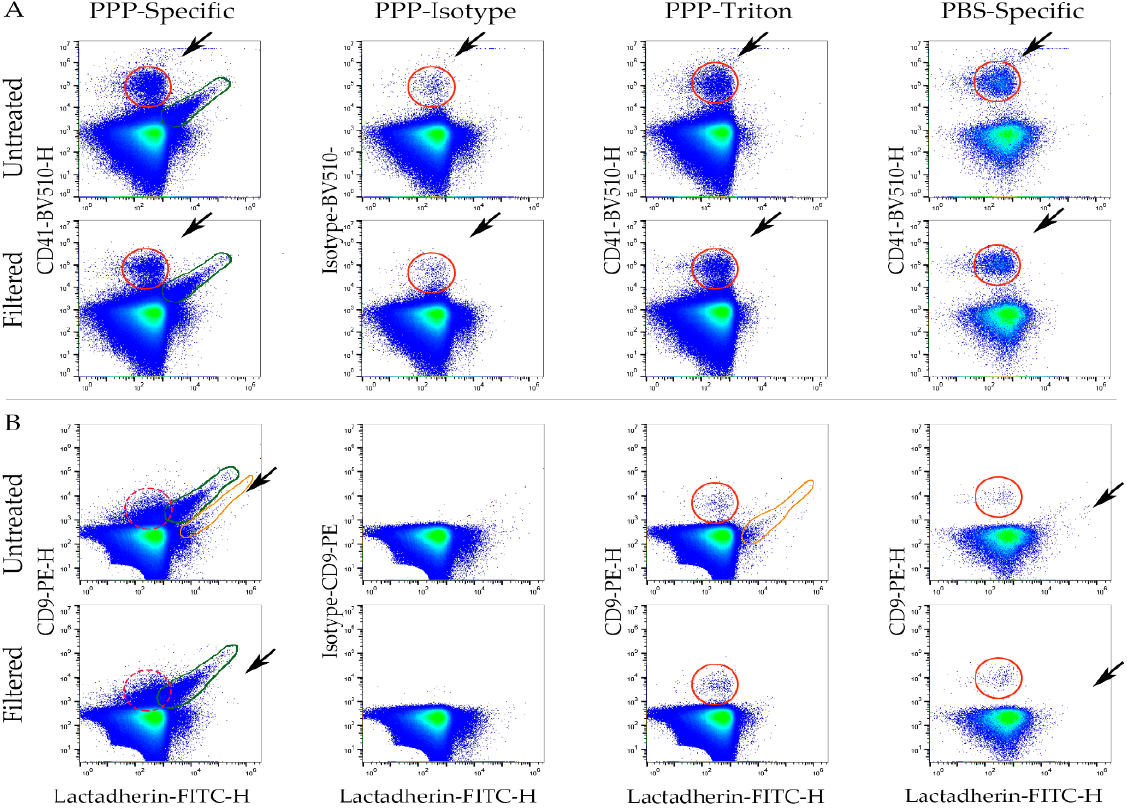
Figure 4. Scatterplots showing ( A ) lactadherin-FITC/CD41-BV510 or ( B ) lactadherin-FITC/CD9-PE of platelet poor plasma (PPP) labeled with panel 3 untreated or filtered labels. Corresponding isotype, triton, and labeled PBS controls are shown. Green circle: lactadherin-FITC+/CD41-BV510+ or CD9-PE+ EV− population. Red circle: CD41− or isotype-BV510+ or CD9-PE+ aggregates. Punctuated red circle: CD9-PE aggregates might be hidden among the CD9+ EV population. Orange circles: lactadherin-FITC+/CD9-PE+ population. This population is not seen in isotype or PBS control or in filtered-specific labeled PPP.